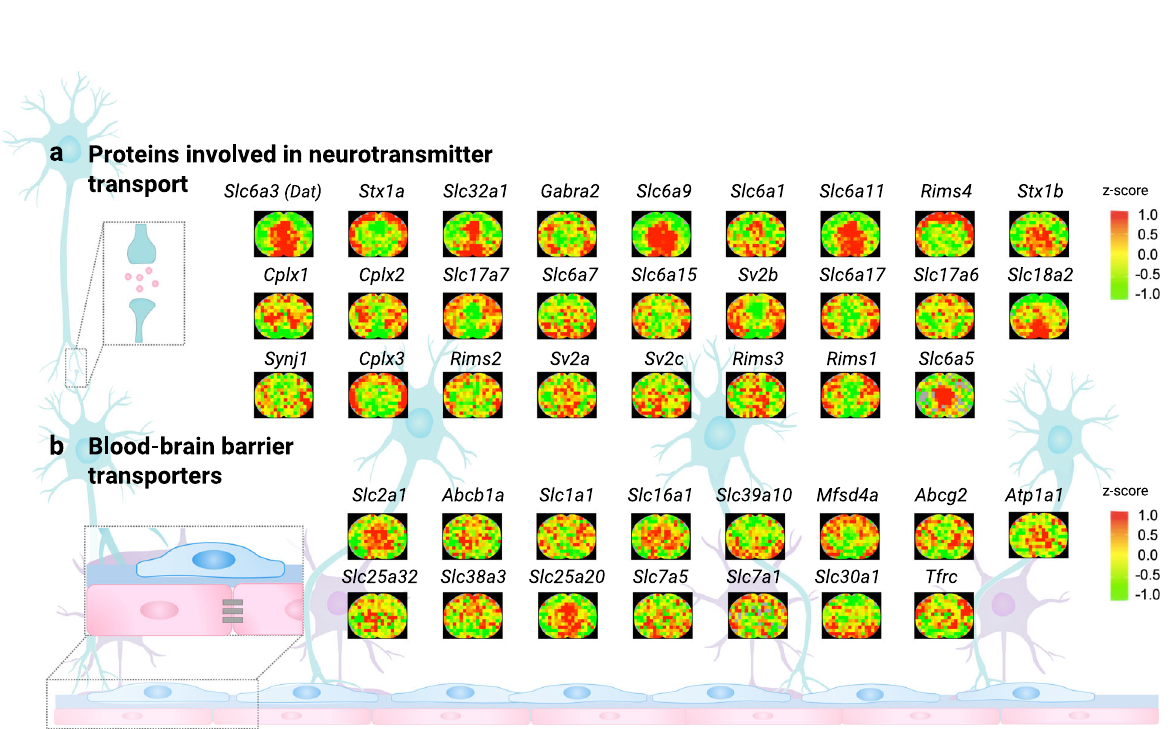
(GO:0006836). b The spatialdistribution maps of the important drug transporters expressed on the blood-brain barrier. The z-score color scale for a , b is from − 1.0 (green) to 1.0